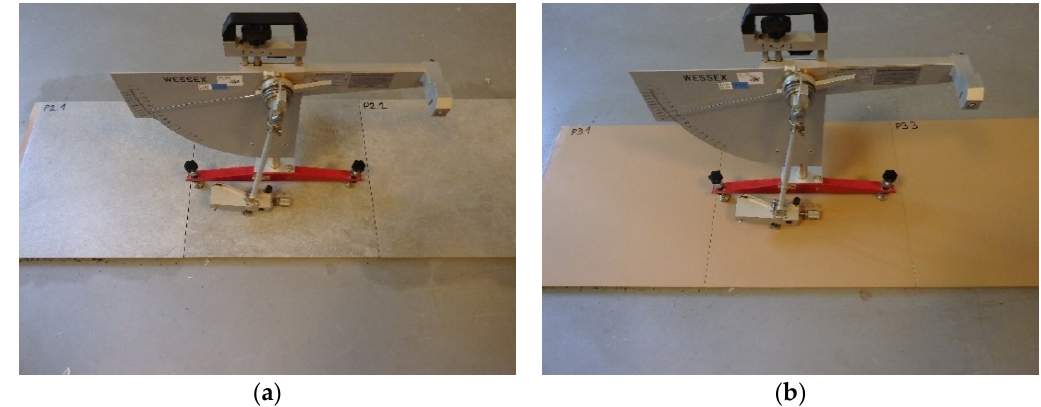
Figure 2. The pendulum test on samples: ( a ) S4 in wet conditions, ( b ) S2 in dry conditions.